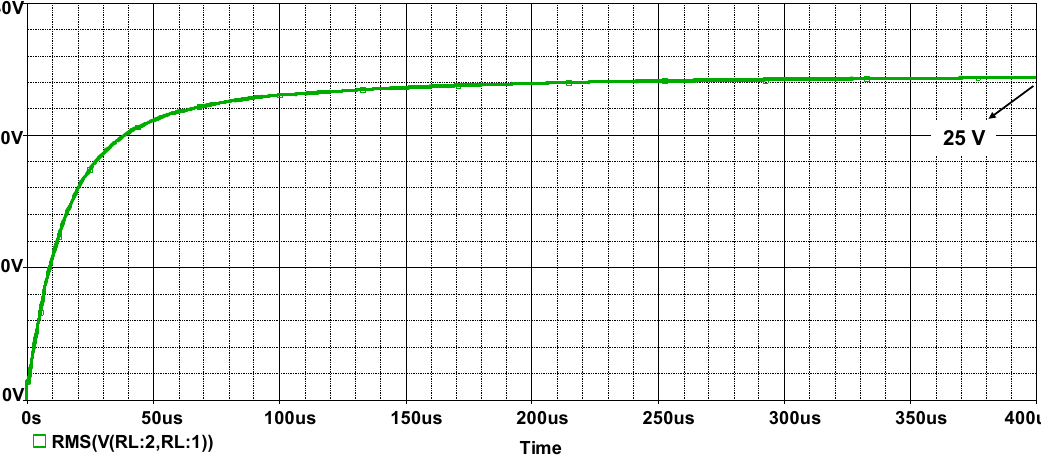
Figure 9. RMS output voltage ( V out ) at the load resistor.